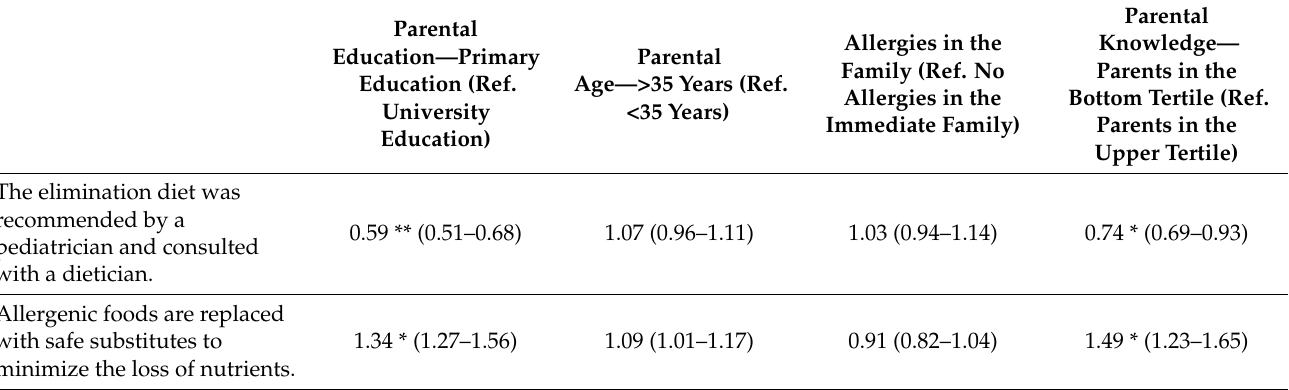
Table 5. Odds ratios (95% confidence interval) of the relationships between parental characteristics, the safety of their children’s diets, and problems with adhering to an elimination